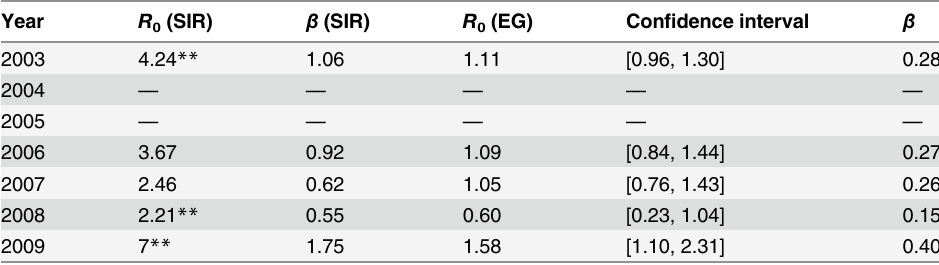
Table 2. First outbreak of influenza. The t -test statistically significant p < 0.05 is marked with ** .